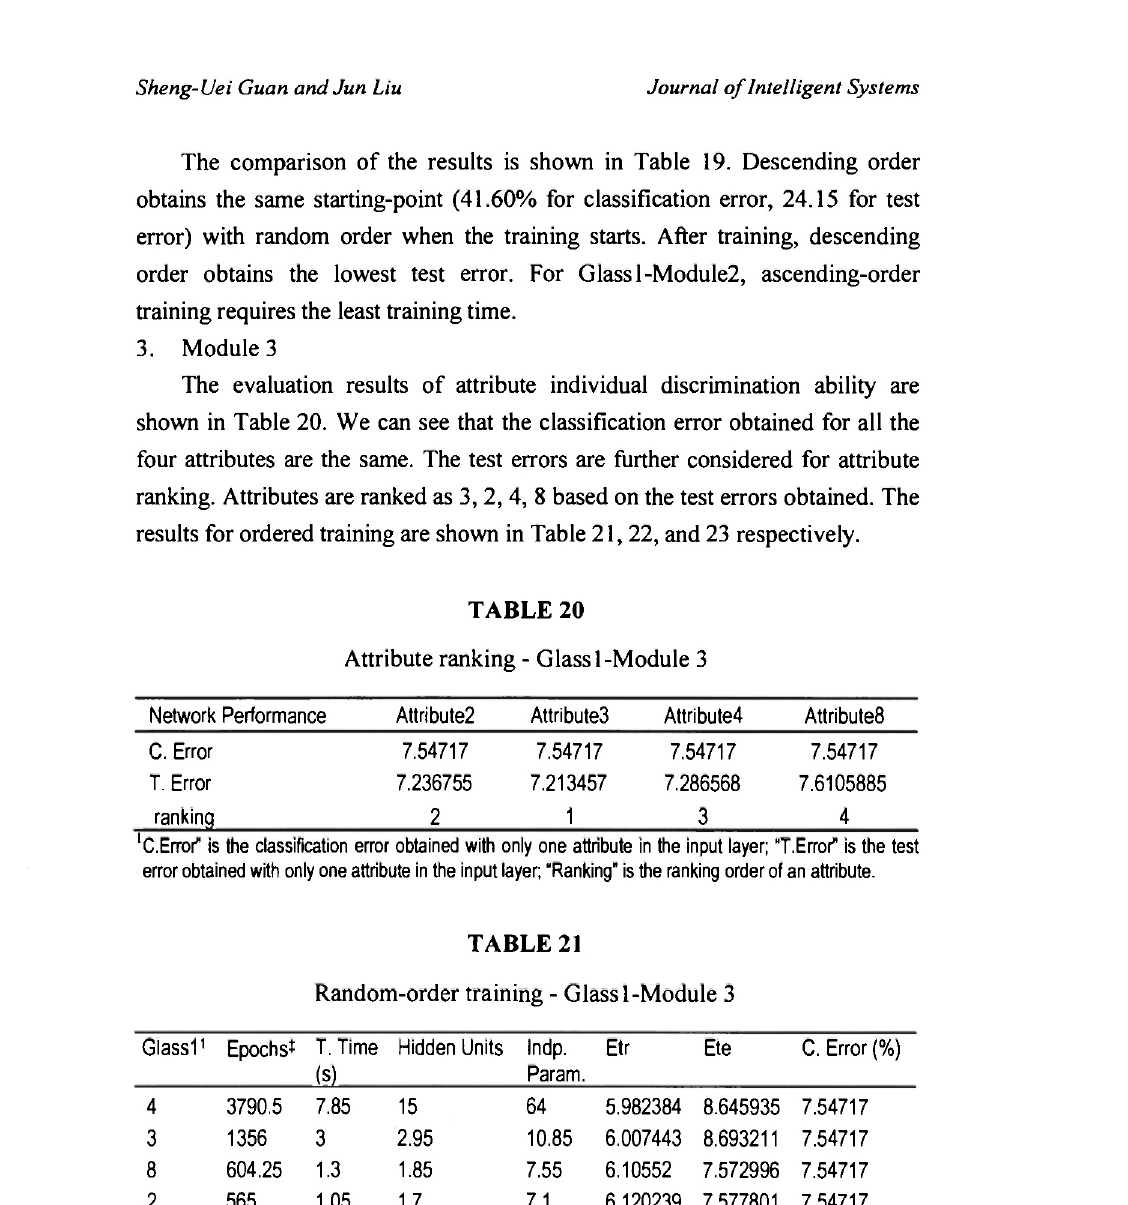
Random-order training - Glass 1-Module